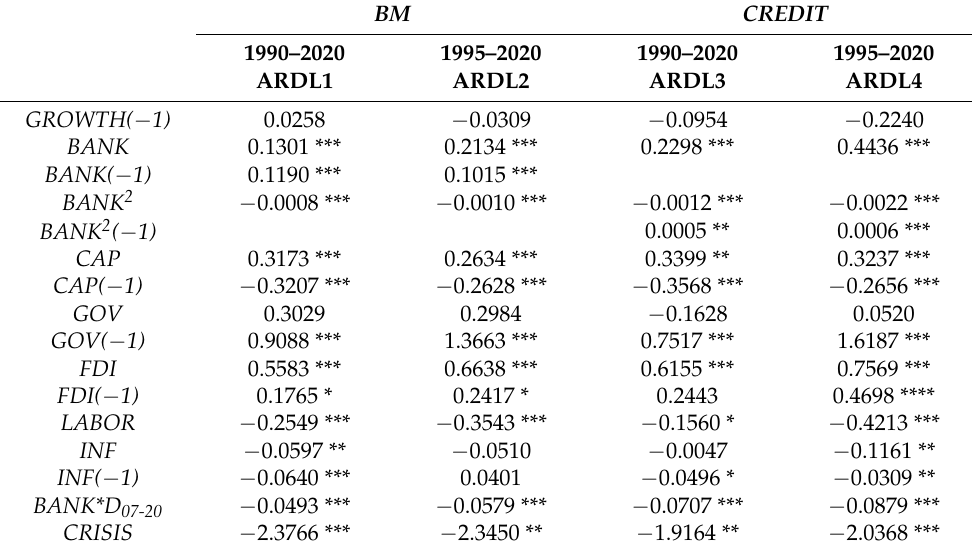
Table 3. Results of cointegration